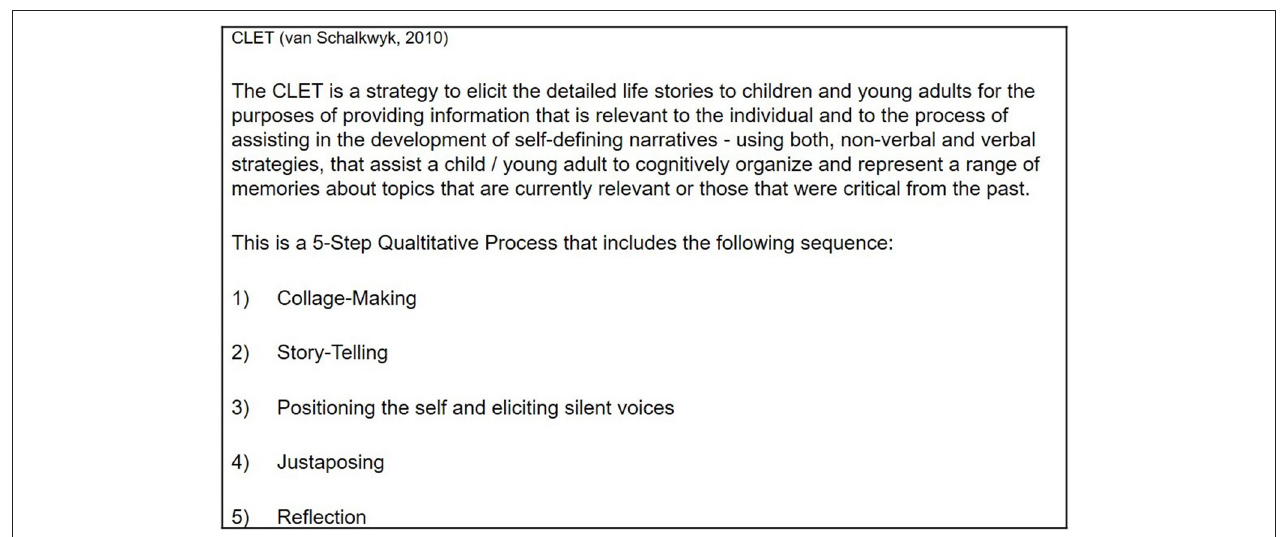
FIGURE 1 | Collage Life Elicitation Technique